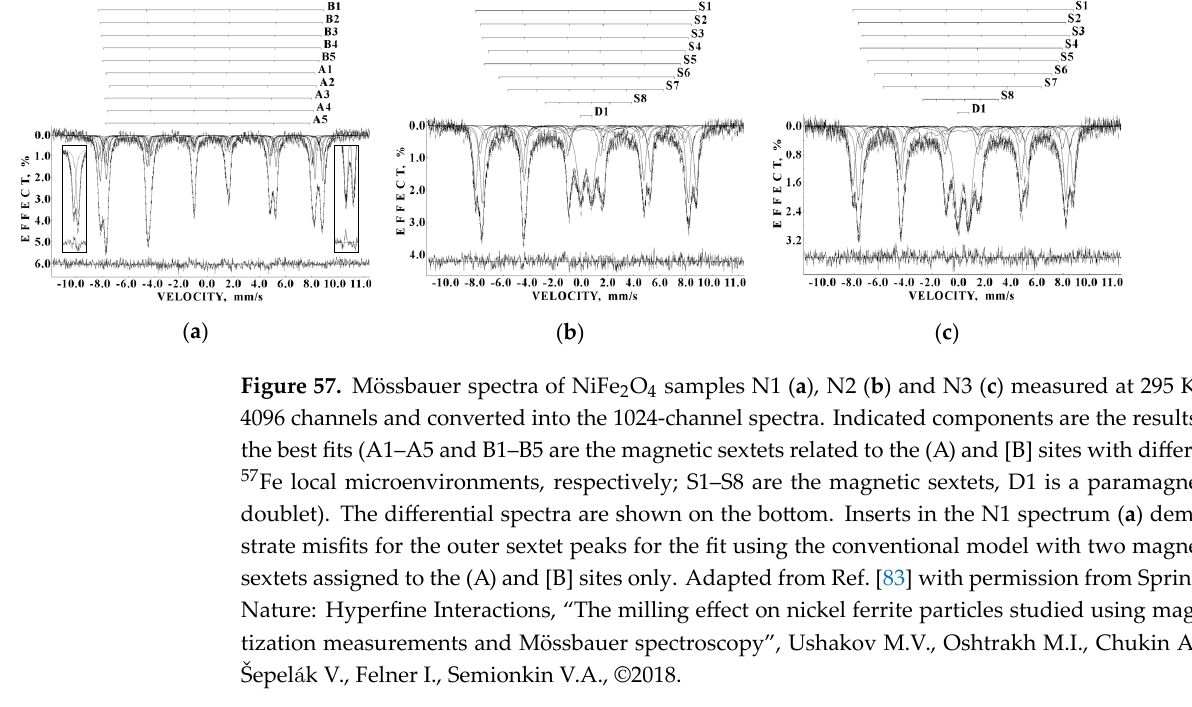
spectra were fitted using eight magnetic sextets and one quadrupole doublet.